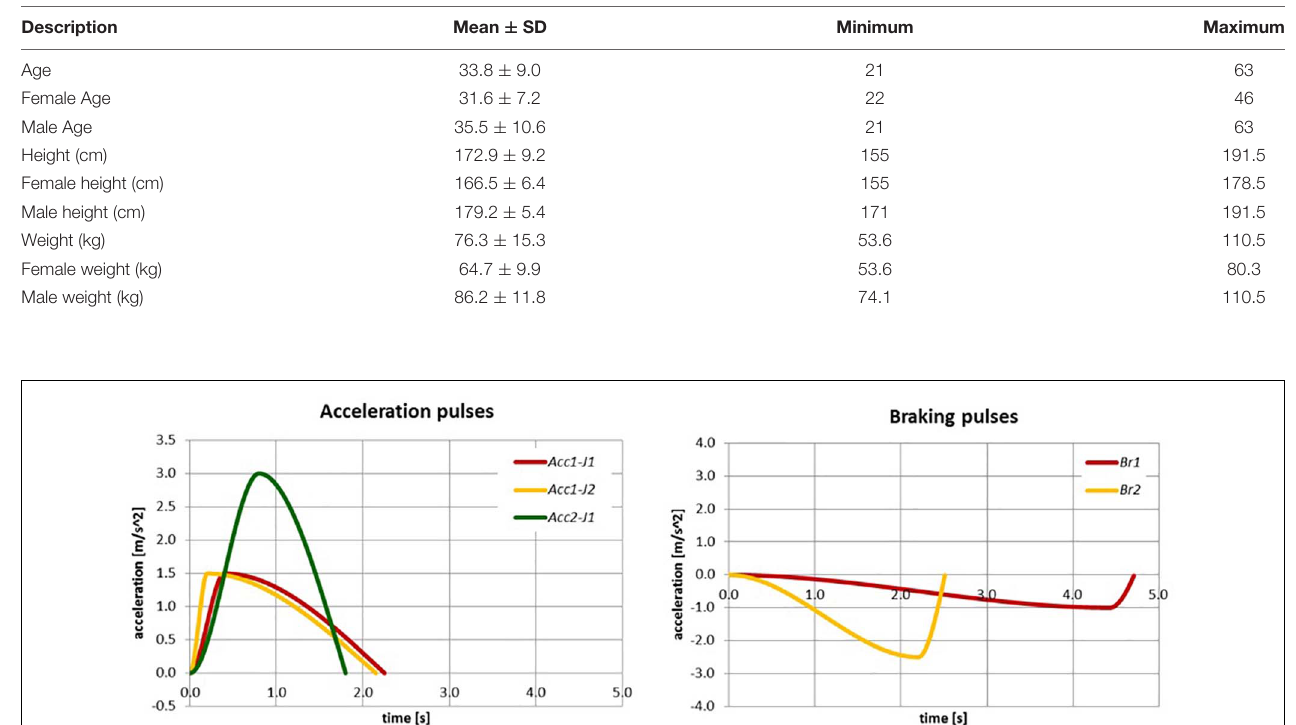
FIGURE 2 | Pulse profile characteristics of acceleration and braking pulses.